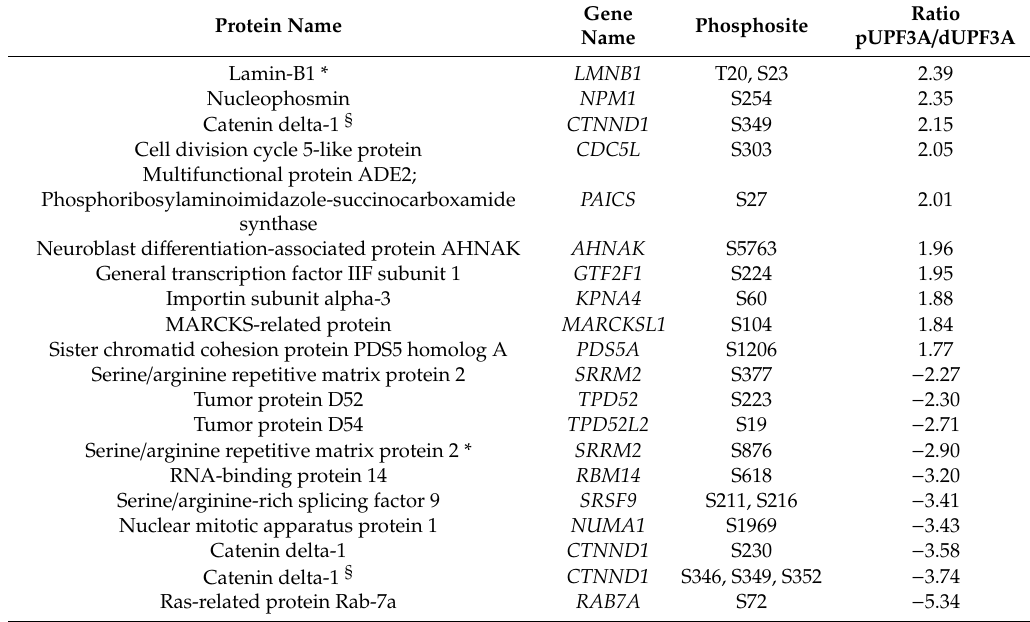
Figure 5. Proteomic data analysis: ( A ) Interaction network of regulated proteins (generated by STRING v11.0). The connecting lines between protein nodes represent protein-protein interactions and the thickness of the edge indicates interaction score (minimum interaction score = 0.4). Coloring of proteins is based on further enrichment analysis. Proteins marked in red are involved in regulation of the cholesterol biosynthetic process. Proteins associated with oxidoreductase activity are marked in blue. ( B , C ) Enrichment analysis of regulated proteins (performed in STRING v11.0). Graphs are showing the most enriched Gene Ontology (GO) Biological Processes ( B ) and Molecular Functions ( C ) among the regulated proteins with observed protein count in each category and calculated p values corrected for multiple testing (Benjamini and Hochberg). Table 5. Top 10 up-regulated and top 10 down-regulated phosphopeptides upon